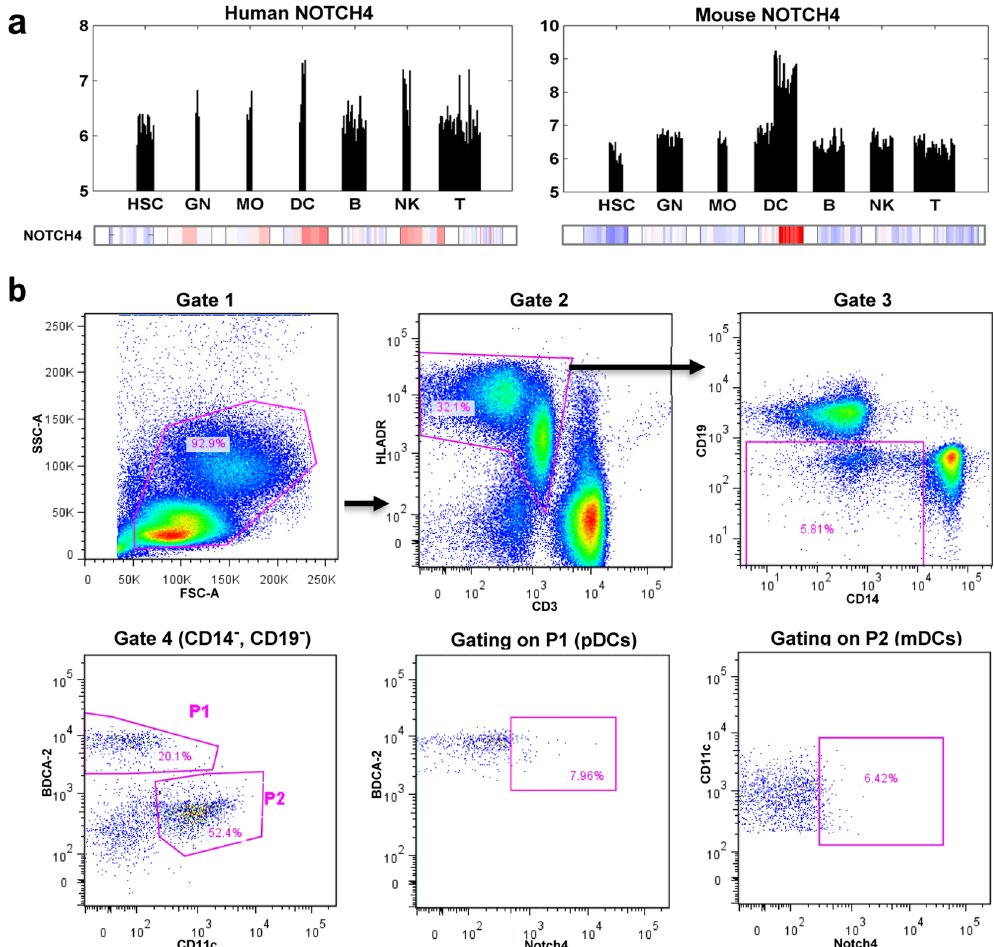
Figure 5. Notch4 is expressed in human dendritic cells. ( a ) Notch4 gene expression profiles from Affymetrix microarray profiling of human and mouse immune cell lineages from different individual human donors (left) or different pools of C57BL/6 (B6) mice (right) from the ImmGen Consortium Database (www.immgen.org). Bar plots (top panel) show absolute NOTCH4 mRNA expression in individual cell lineages in the indicated cell types. Heatmaps show mean-centered gene expression values (red bars denote enrichment above background). NOTCH4 mRNA is expressed in dendritic cells in both human and mouse, whereas expression in NK cells is detected only in humans. ( b ) Representative density plots from flow cytometric analysis show gating strategy and expression of Notch4 in plasmacytoid and myeloid dendritic cell subpopulations in PBMCs (one representative donor from a total of n = 3 healthy donors). HSC, Hematopoietic stem cells; GN, Neutrophils; MO, Monocytes; DC, Dendritic cells; B, B lymphocytes; NK, Natural killer cells; T, T